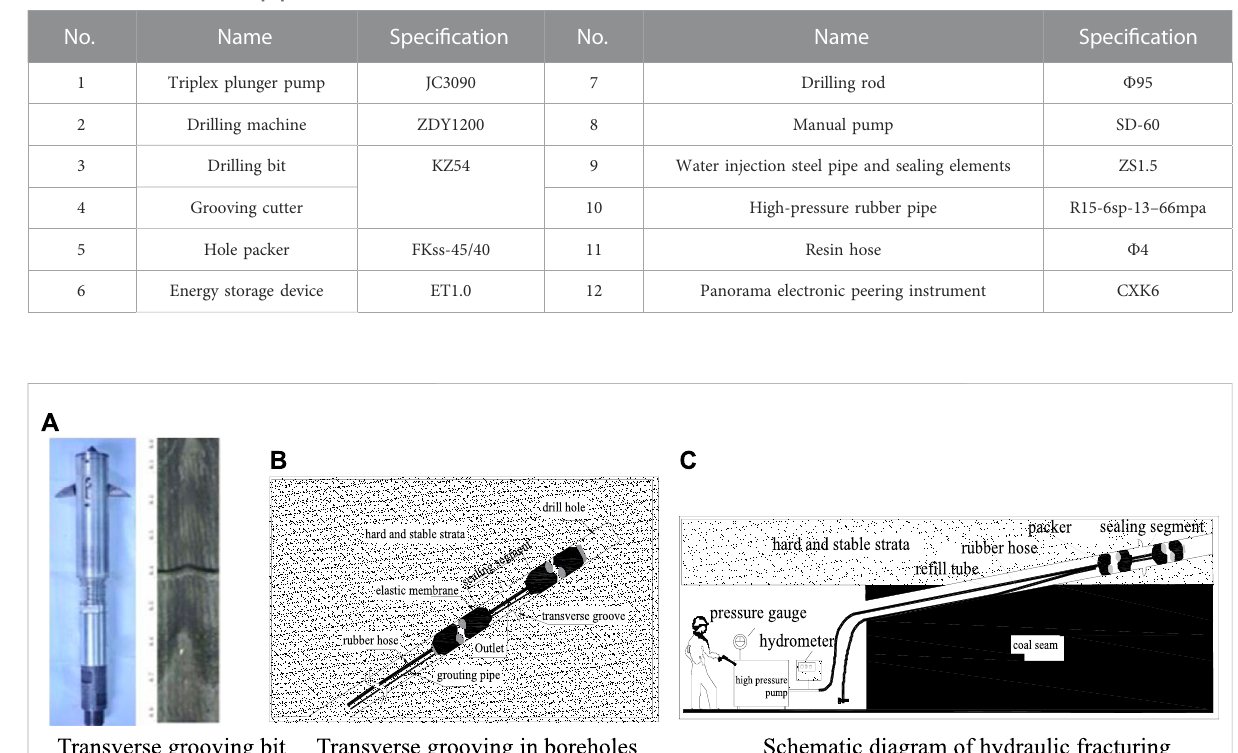
FIGURE 6 Diagram of hole sealing and construction technology of the straddle expansion packer. (A) Transverse grooving bit; (B) transverse grooving in boreholes; (C) schematic diagram of hydraulic